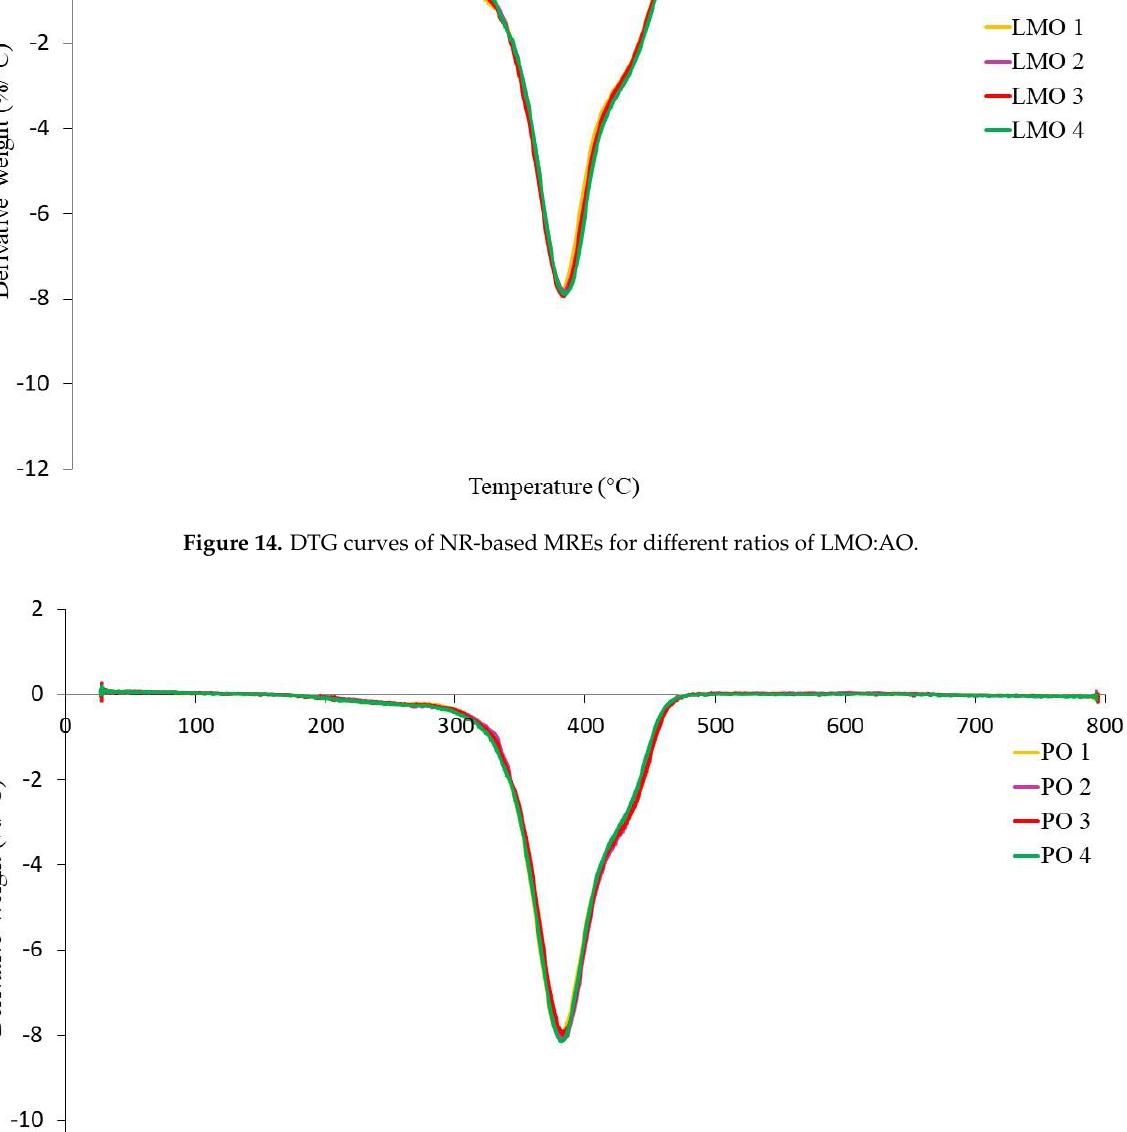
Figure 15. DTG curves of NR-based MREs for different ratios of PO:AO.